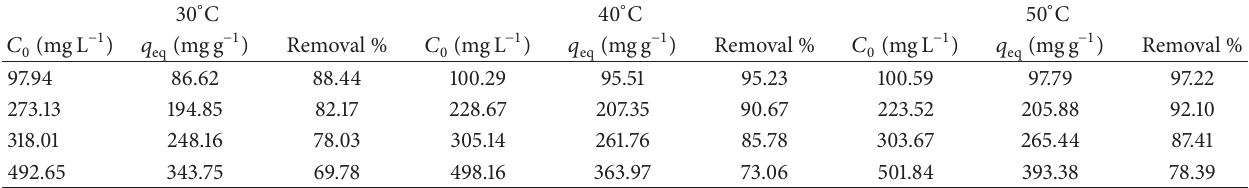
Table 4: Effect of initial TB AGLF dye concentration and temperature on the equilibrium capacity and removal % of sunflower pulp.